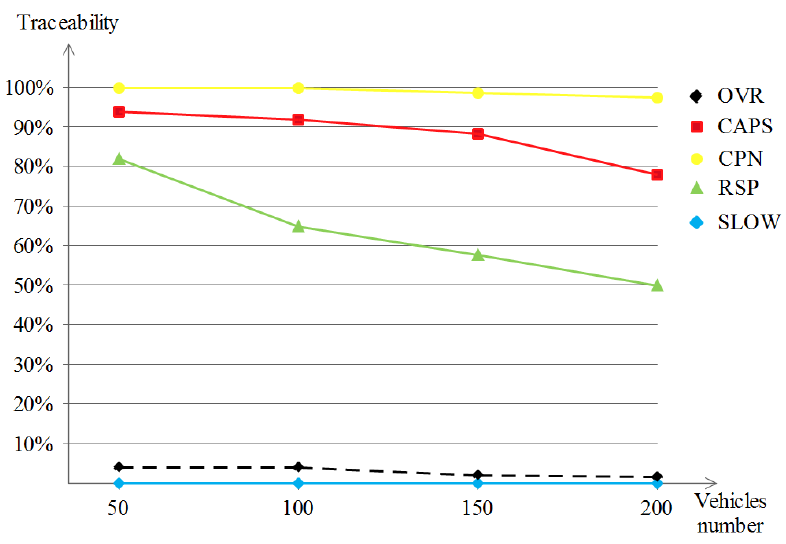
Figure 9. Traceability of privacy schemes in the Manhattan